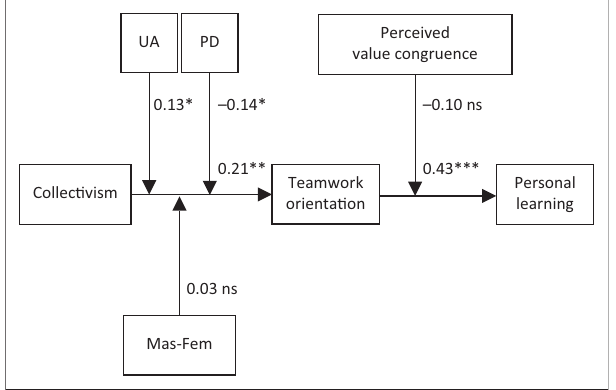
FIGURE 4: Simple slope: Power distance as a moderator between the effect of collectivism on individual team